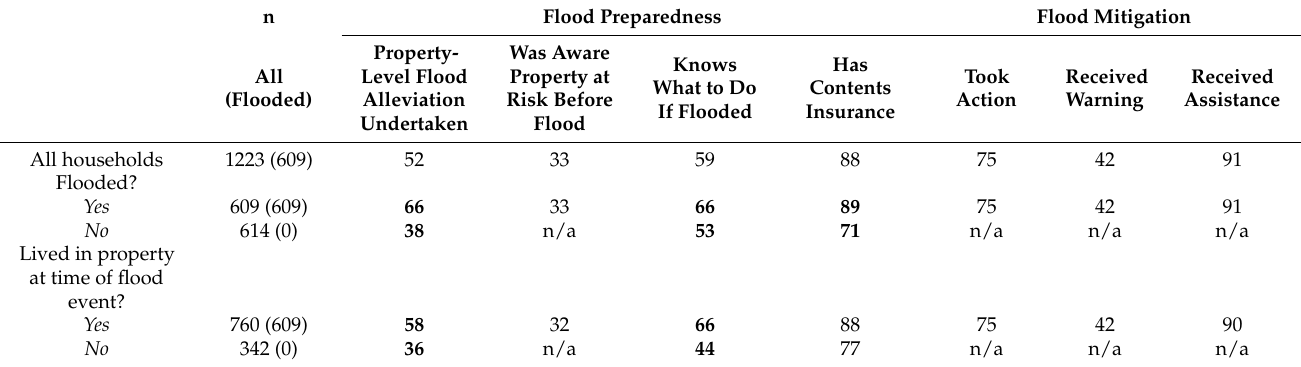
Table 4. Flood resilience by flood history. (% of